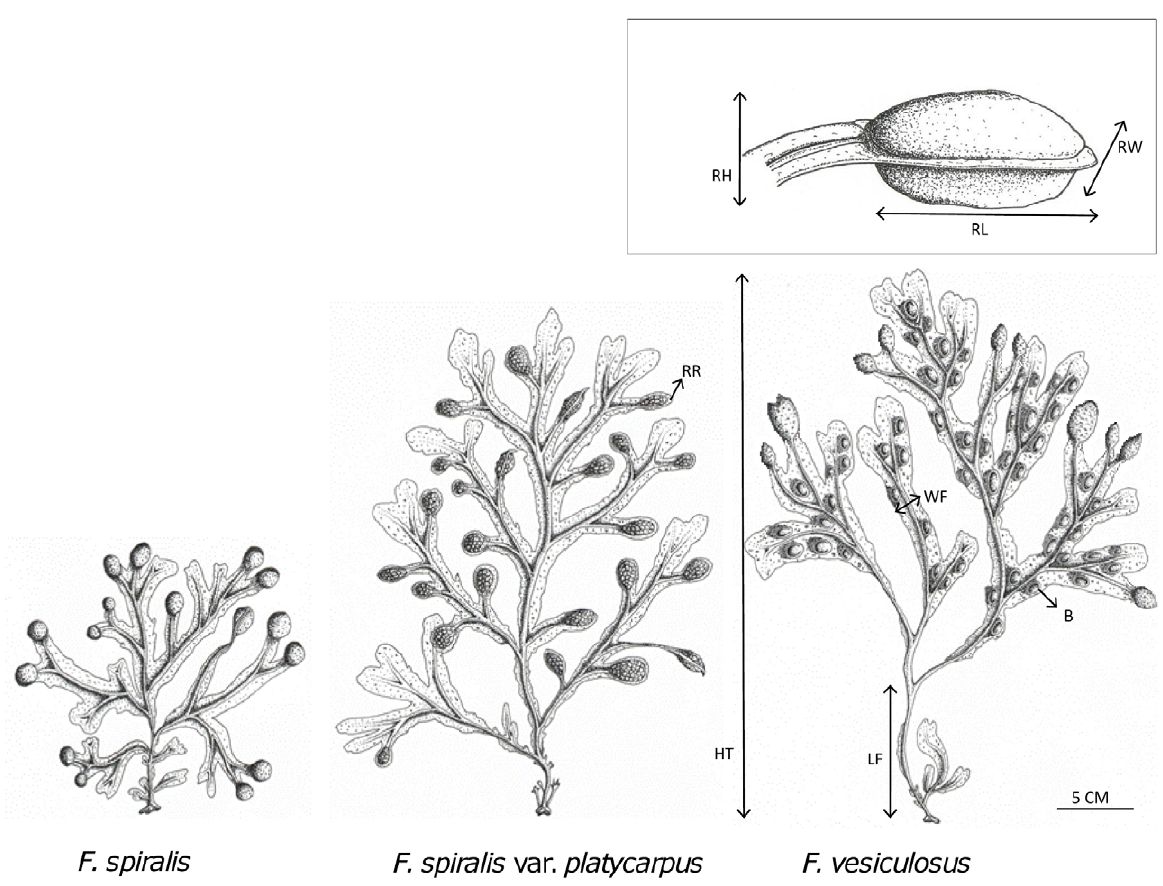
Figure 2. Drawings of morphotypes and illustration of morphological traits. Drawings of the three morphotypes. Added in the last drawing, illustration of measurements used to characterize morphotypes. Illustration of measurements used for the receptacles in the insert at the top. All traits are listed by abbreviation (see text for full explanation).